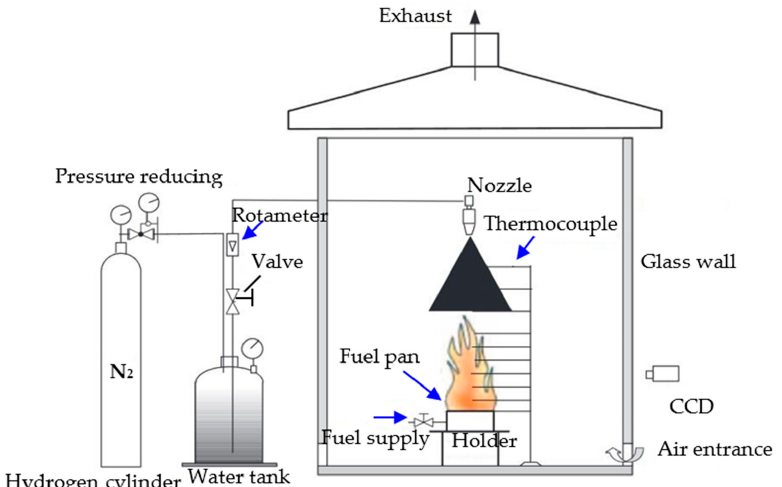
Figure 8. Schematic of liquid pool fire with water mist system additives experimental apparatus [18].